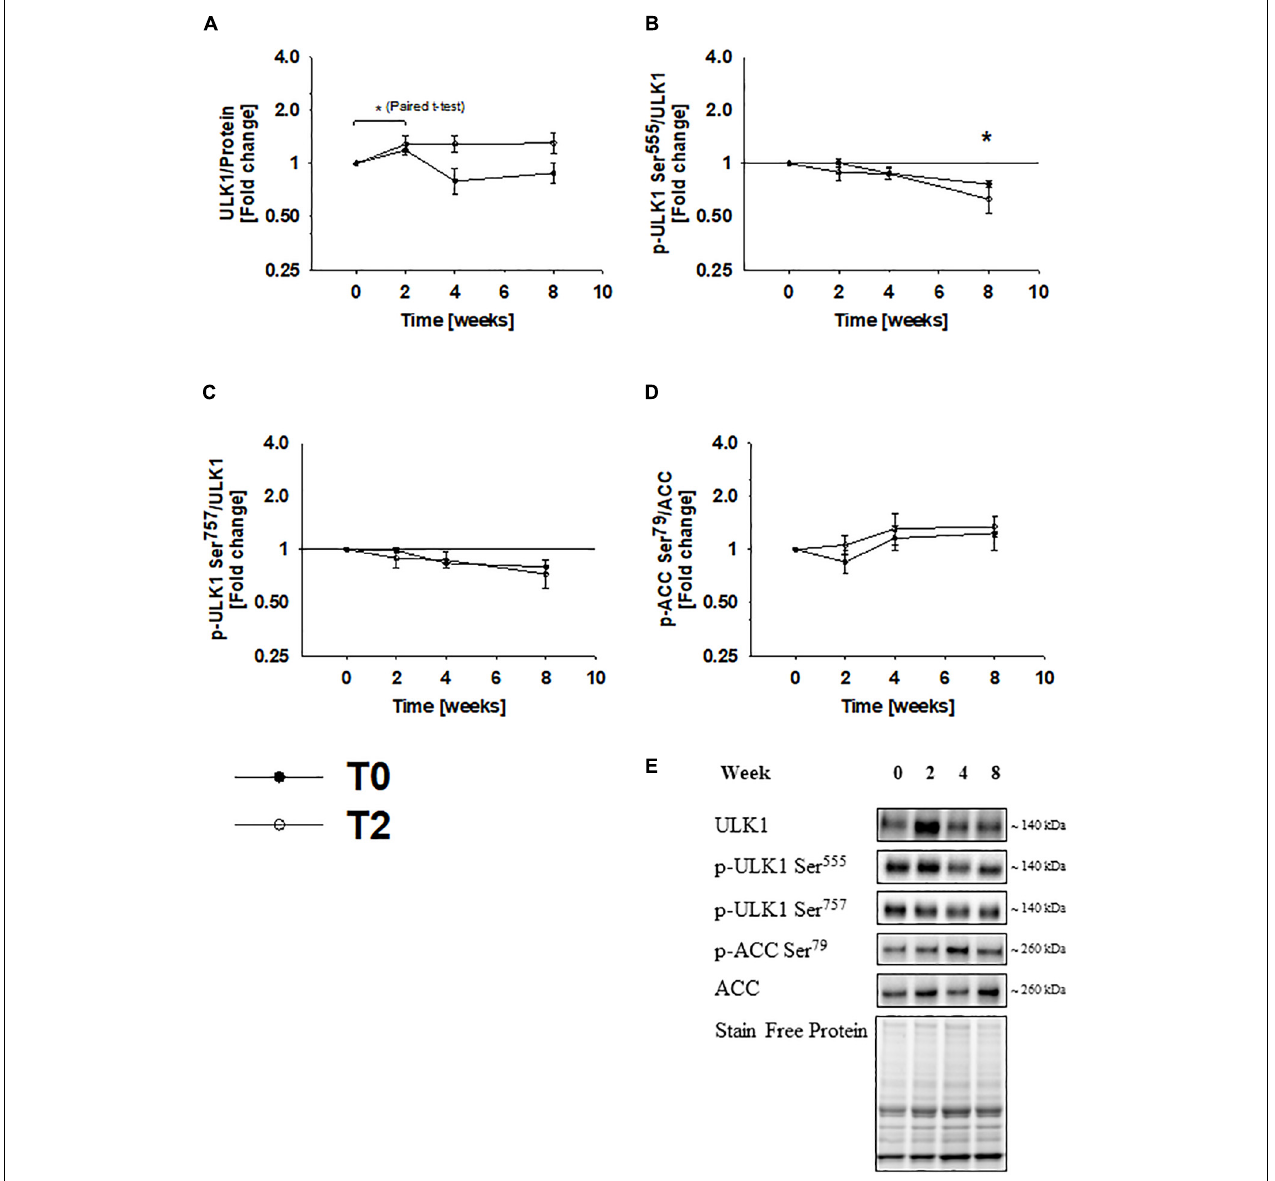
FIGURE 5 | Autophagic signaling trough ULK1 remains unchanged during immobilization and rehabilitation. Based on the mixed linear model with repeated measurements, the change in ULK1 protein expression did not reach statistical significance. However, when a paired t -test was used, ULK1 protein expression increased during immobilization and tended decreased toward baseline levels during rehabilitation (A) . ULK1 phosphorylation at Ser 555 and Ser 757 did not change during immobilization and rehabilitation (B,C) . ACC phosphorylation at Ser 79 did not change throughout the study (D) , suggesting that AMPK activity remained unaltered. Values are geometric means ± back-transformed SE. ∗ Post hoc test showed significant change during immobilization. Representative western blots (E) . Based on the applied molecular standards, approximated molecular weights are indicated on the right. Filled symbols represent subjects from T0 and open symbols represent subjects from